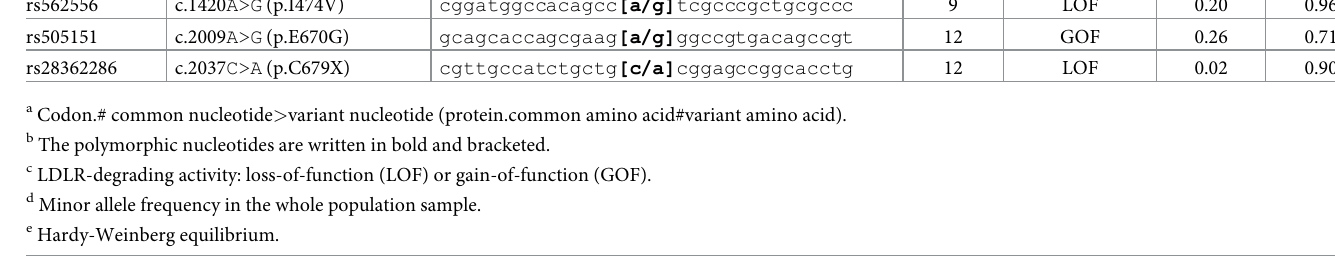
Table 1. PCSK9 SNPs under study.